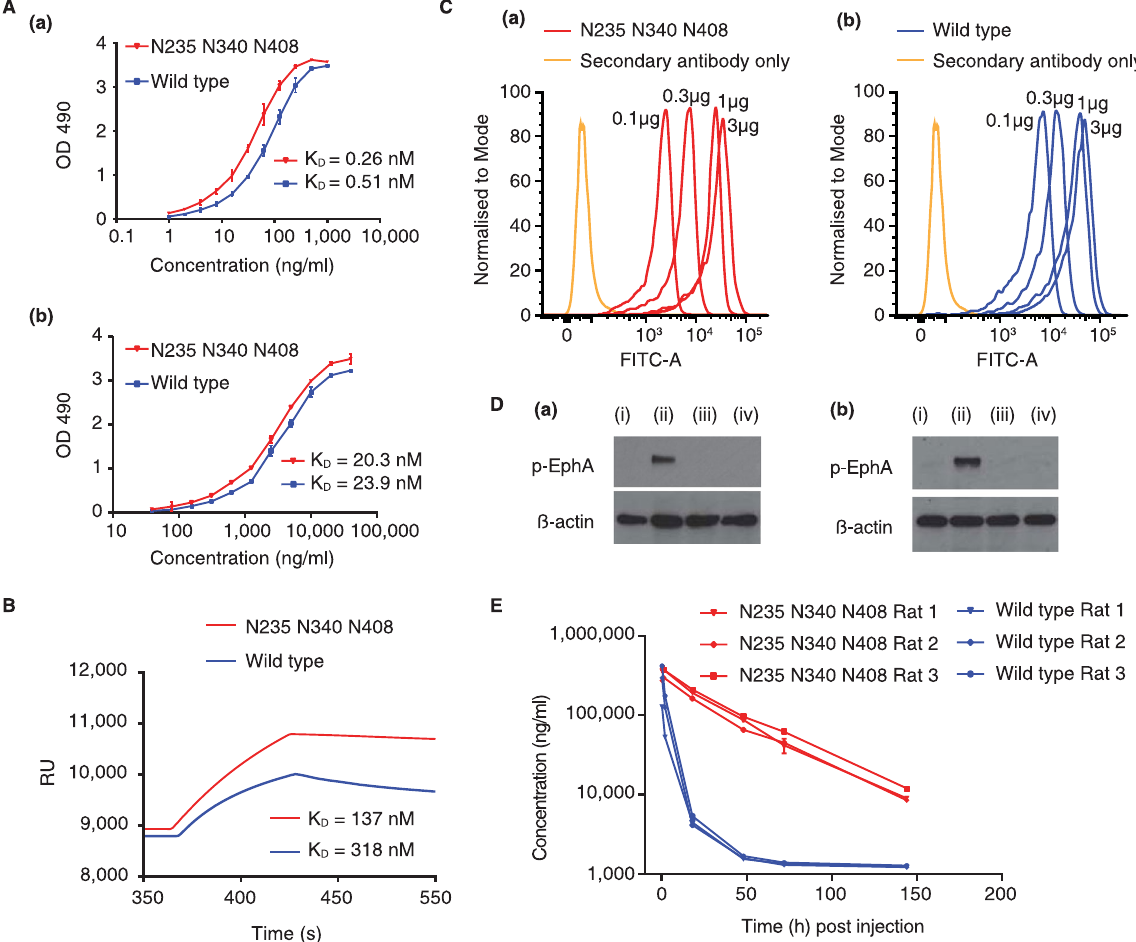
Figure 3. Ligand-binding and pharmacokinetic analyses of the triple mutant of EphA4 Fc compared to the wild type protein. ( A ) Ephrin-binding ELISA of the triple mutant and wild type EphA4 Fc proteins with immobilised ephrin-A5 Fc (a) and ephrin-B3 Fc (b). The apparent dissociation constants (K D ) values are shown for the triple mutant and wild type proteins. ( B ) Kinetic analyses of the interactions of the wild type and triple mutant EphA4 Fc proteins were determined by surface plasmon resonance measurements using a BIAcore biosensor with sensorchip surfaces immobilised with ephrin-A5 Fc. ( C ) Flow cytometric analysis of binding of the triple mutant (a) and wild type (b) EphA4 Fc proteins to ephrin-A5 expressing CHO cell line. ( D ) Inhibition of receptor activation using EphA4 stably transfected CHO cell line and pre-clustered (a) ephrin-A5 Fc (b) ephrin-B3 Fc with (i) unstimulated (ii) pre-clustered ephrin (iii) pre-clustered ephrin with wildtype EphA4 and (iv) pre-clustered ephrin with mutant EphA4. ( E ) Sandwich ELISA of the triple mutant and wild type EphA4 Fc protein clearance in Rattus norvegicus